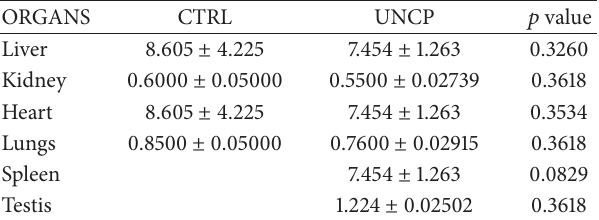
Table 4: Changes in relative organ weight of male SD rats dosed with 2000 mg/kg body weight of UNCP solution.